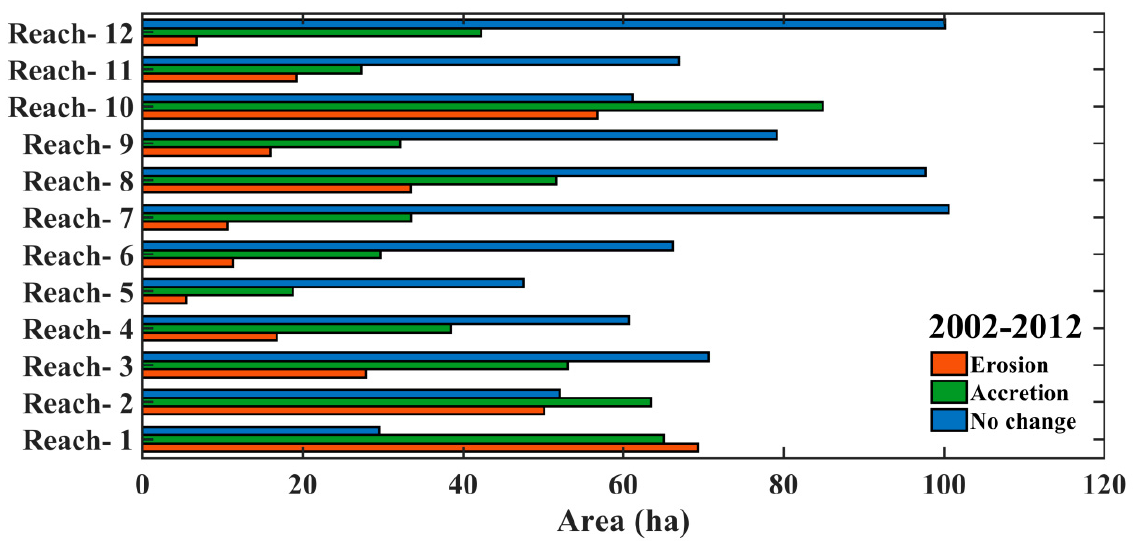
Figure 9. Map of erosion, accretion, and unchanged area between 2002–2012.